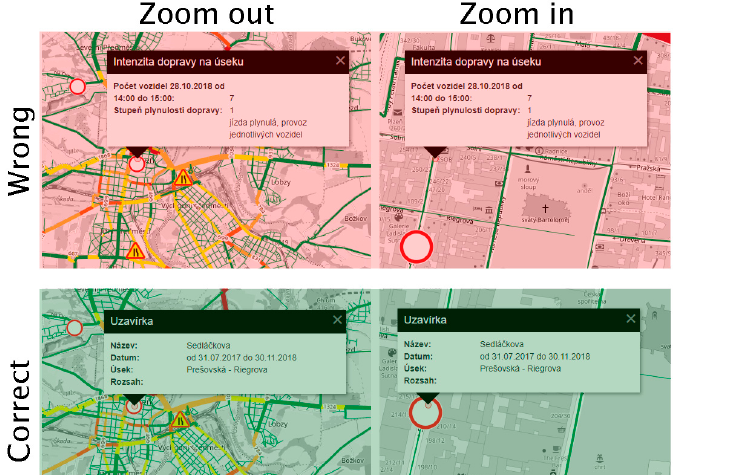
Table 4. Problems identified with the Flanders map.